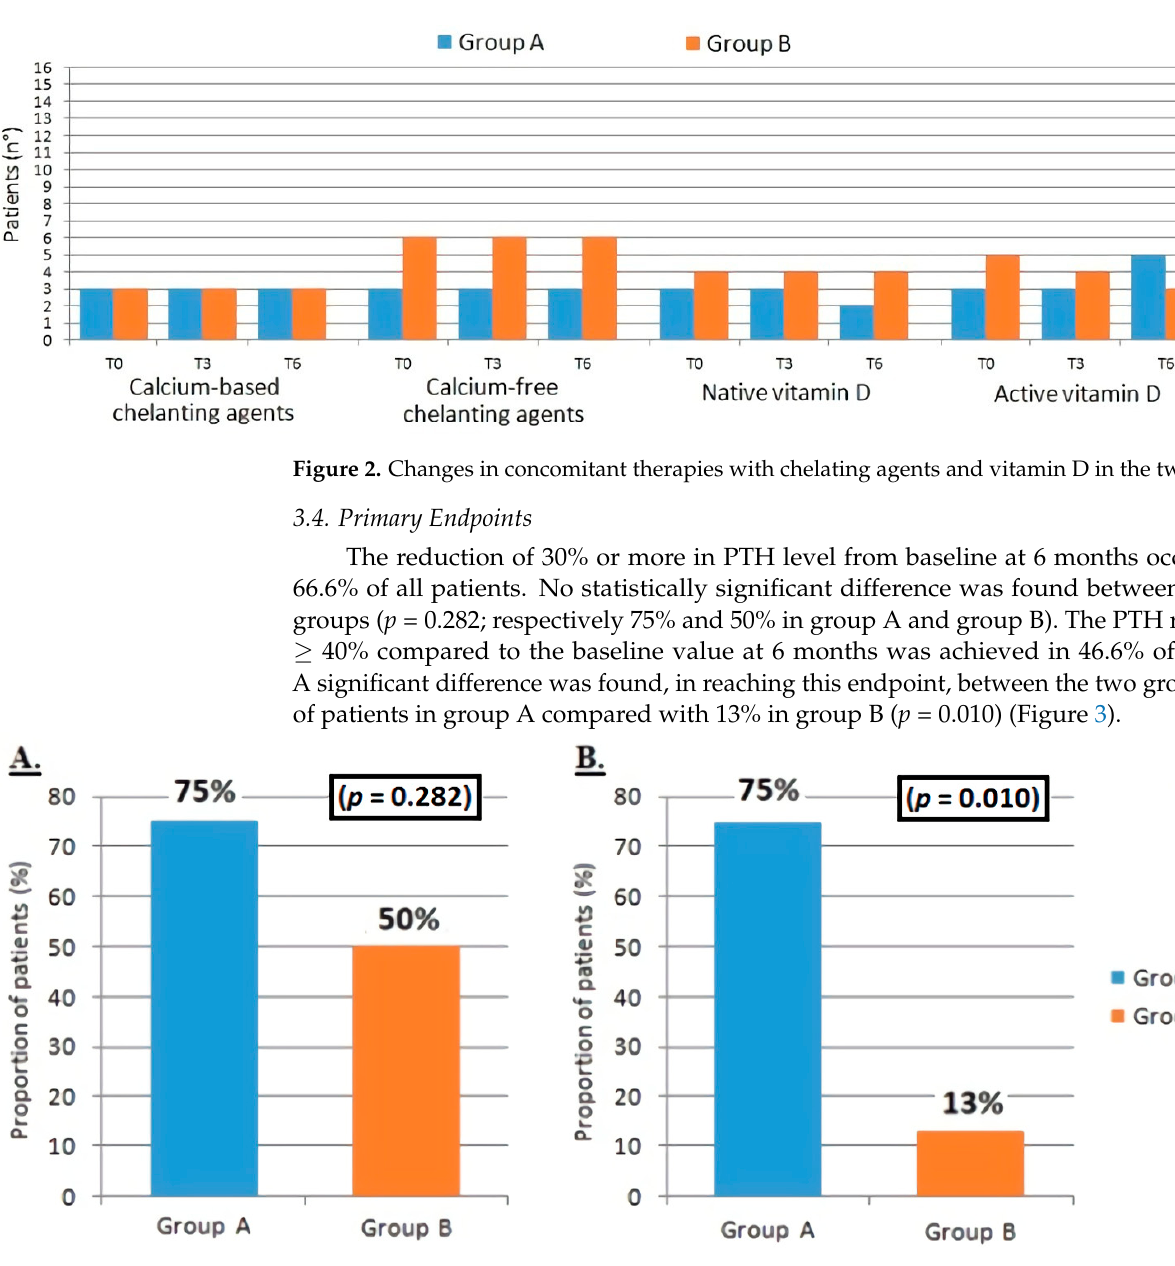
Figure 3. Difference between group A and group B in achieving primary endpoints. ( A ) Reduction in the mean value of PTH ≥ 30% compared with the baseline value at 6 months from the start of treatment with etelcalcetide. ( B ) Reduction of the mean value of PTH ≥ 40% compared with the baseline value at 6 months from the start of treatment with